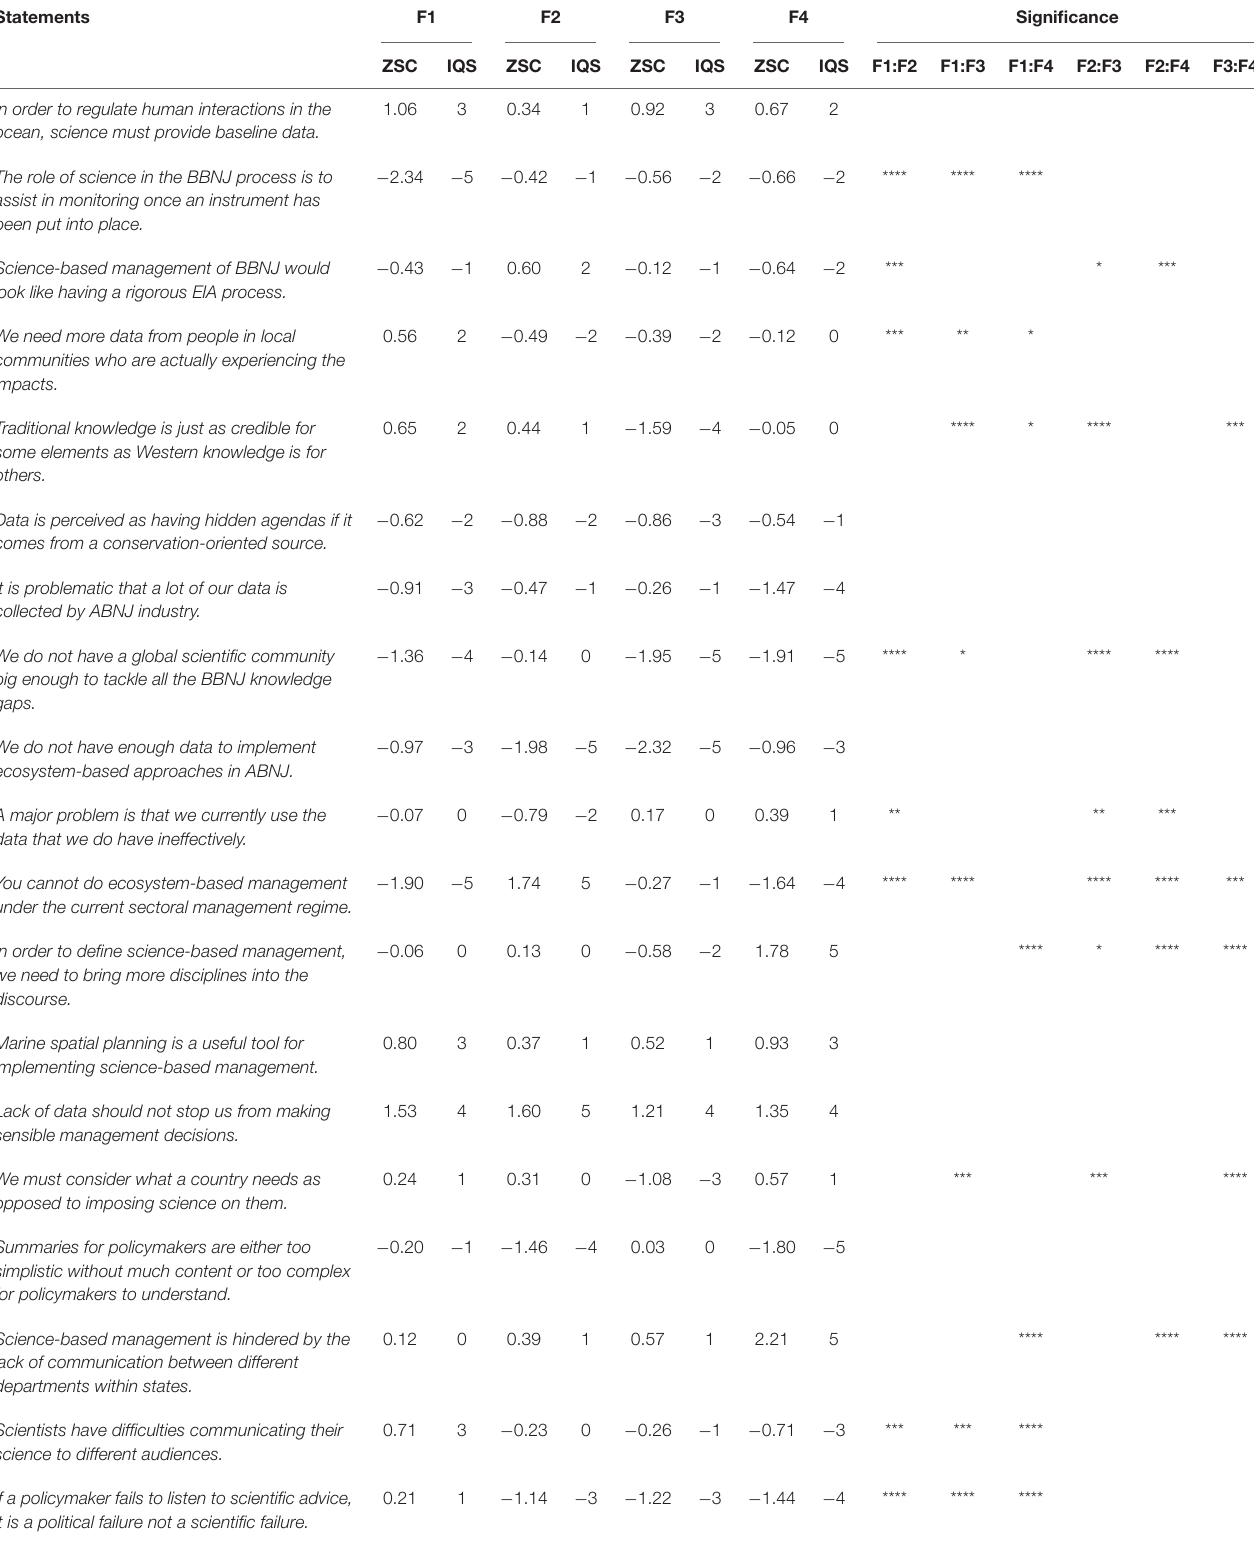
TABLE 2 | Z -scores (ZSC) and idealised Q-sort scores (IQS) for factors